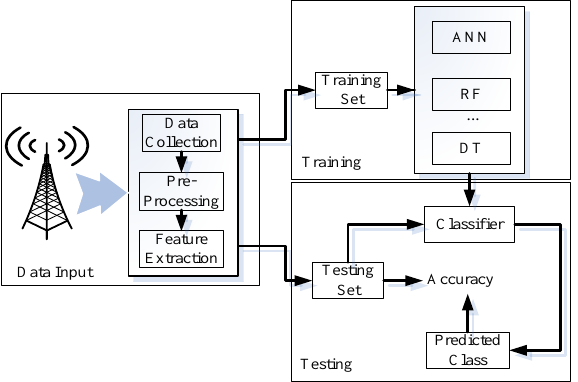
Figure 1. Framework of indoor/outdoor detection. This framework contains three processes: Data Input, Training, and Testing. In the Data Input process, neighboring cellular base stations’ signal strength is recorded, and features are extracted. The data are classified in the Training phase. The classifier is applied to detect the user’s current environment in the Testing phase.